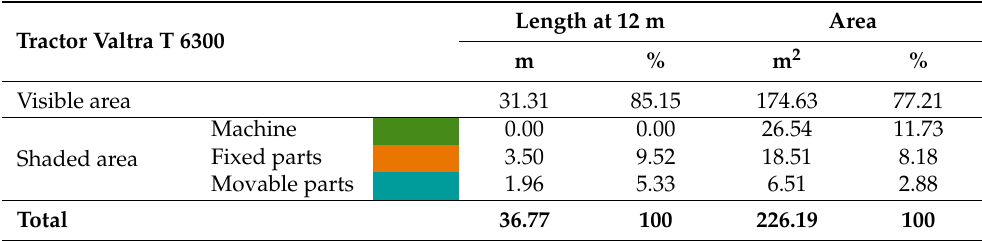
Table 1. Data on length and area characterizing the forward view of the driver of agricultural trac- tor.